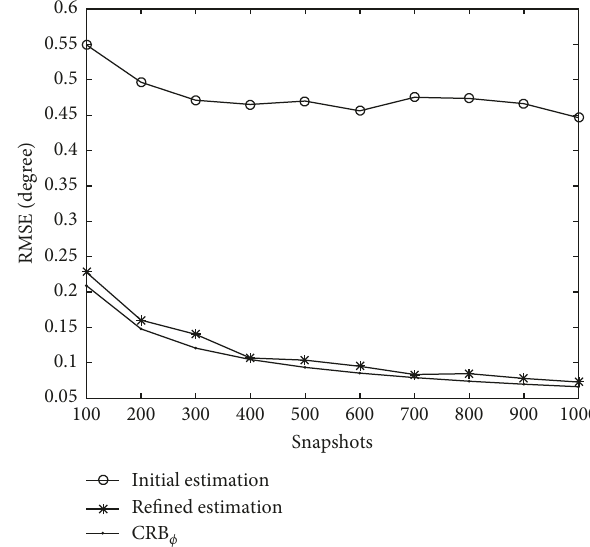
Figure 7: Angle estimation performances with different SNR.